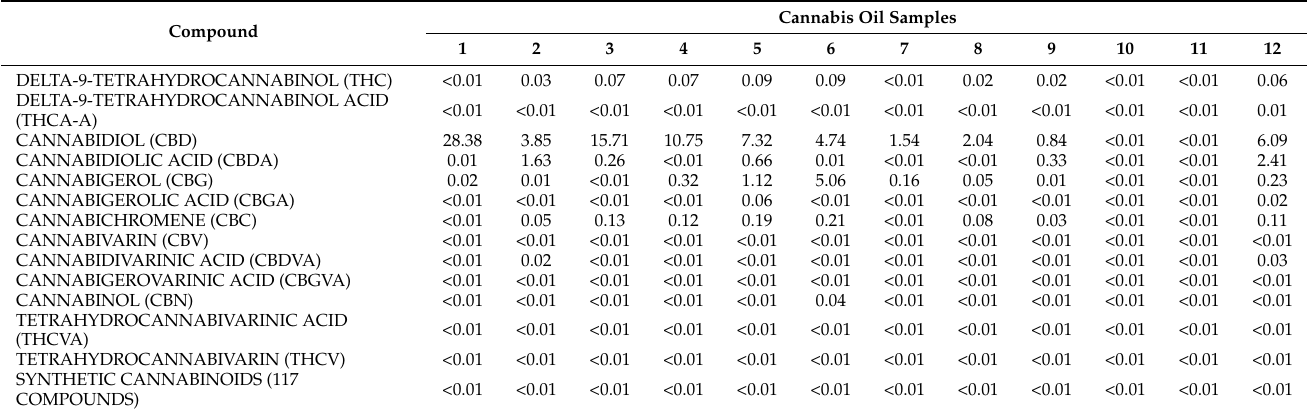
Table 1. Analysis of cannabinoids concentration in cannabis oil